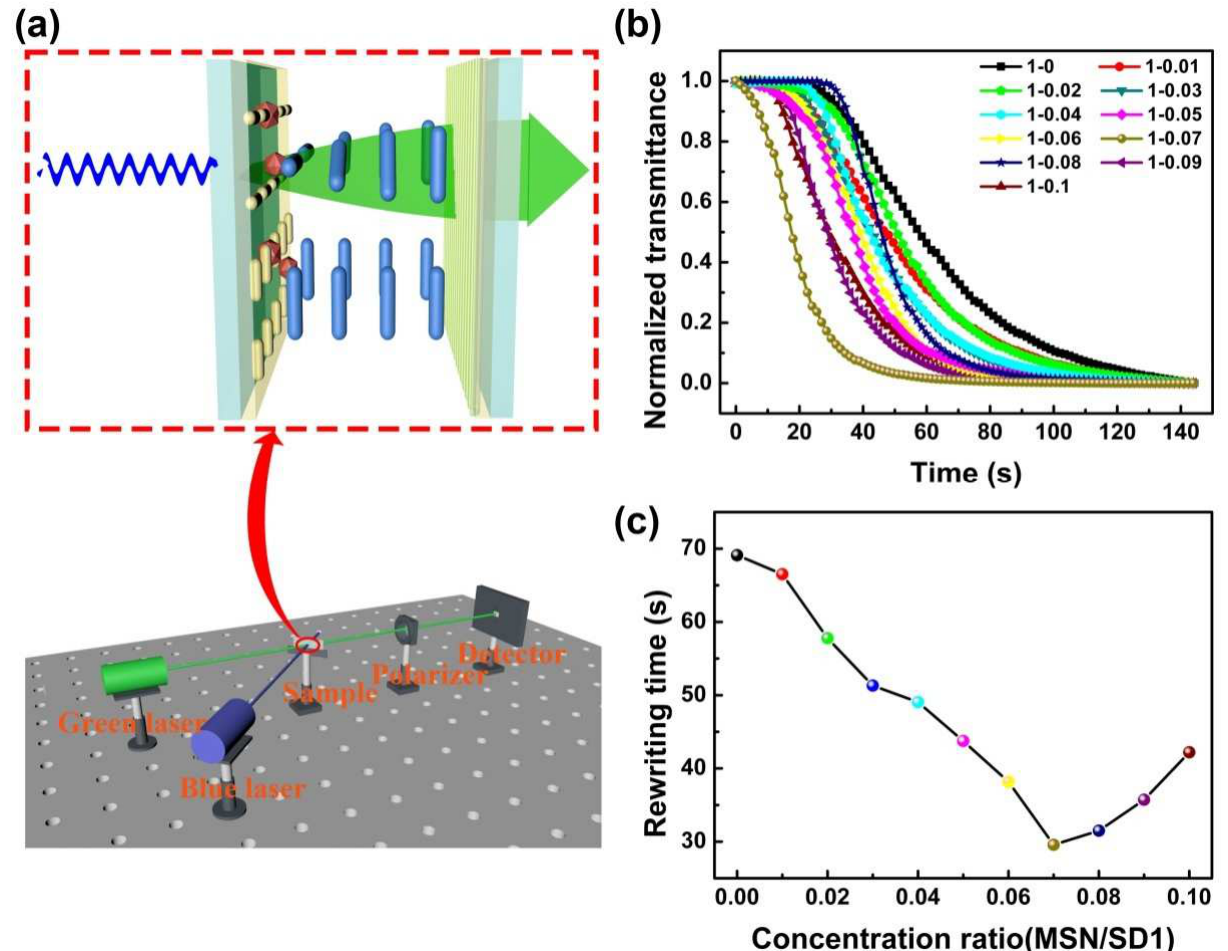
Figure 4. ( a ) Schematic diagram of ODLCD rewriting time measurement. ( b ) Normalized trans- mittance of LC cell with different MSN/SD1 ratios as a function of time. ( c ) The average rewriting time of 11 different SD1-MSN ratios. Table 1. Comparison of rewriting time of this work and several reported works.